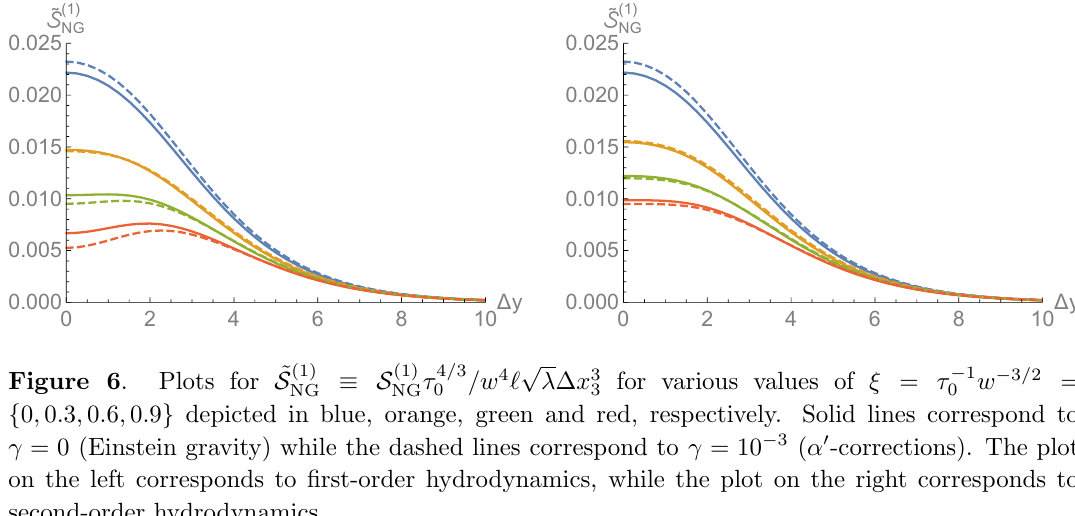
p (cid:17) S (1) (cid:28) 4 = 3 =w 4 ‘ (cid:21) (cid:1) x 3 for various values of (cid:24) = (cid:28) (cid:0) 1 3 0 NG NG